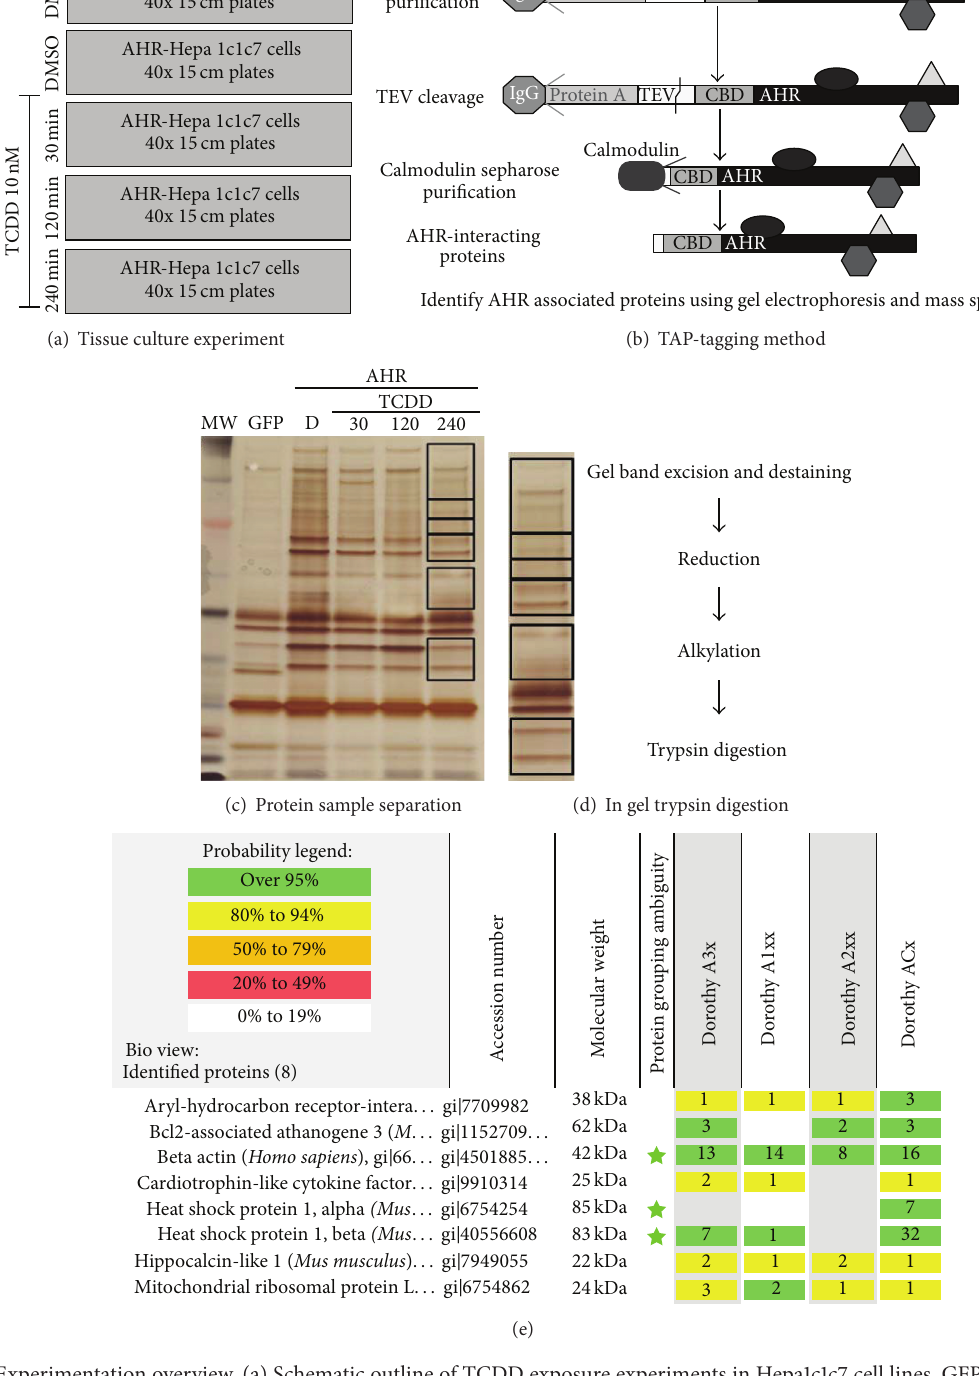
Figure 1: Experimentation overview. (a) Schematic outline of TCDD exposure experiments in Hepa1c1c7 cell lines. GFP and AHR samples were treated with vehicle (DMSO (D), 0.01%); the remaining three AHR samples were treated with TCDD (10nM) for the labeled time (30, 120, and 240 mins). (b) Schematic of the tandem affinity purification (TAP) protocol. After TCDD exposure, cell lysate samples underwent two rounds of purification utilizing the TAP methodology. AHR and GFP TAP-tagged proteins and their associated complexes were isolated and then separated using gel electrophoresis. (c) Representative image of gel replicates for final TAP eluate samples separated in 4–12% Nu- page gel matrix. Boxes around the areas of the AHR-TAP 240 min TCDD dose sample lane denote the areas of the gel that were excised from each of the sample lanes. (d) Schematic of the in-gel trypsin digestion protocol. Excised gel samples were destained, and proteins underwent reduction, alkylation, and trypsin digestion. (e) Sample of MS analysis data set. Lastly, the protein fragment samples then underwent MS analysis as described in Section